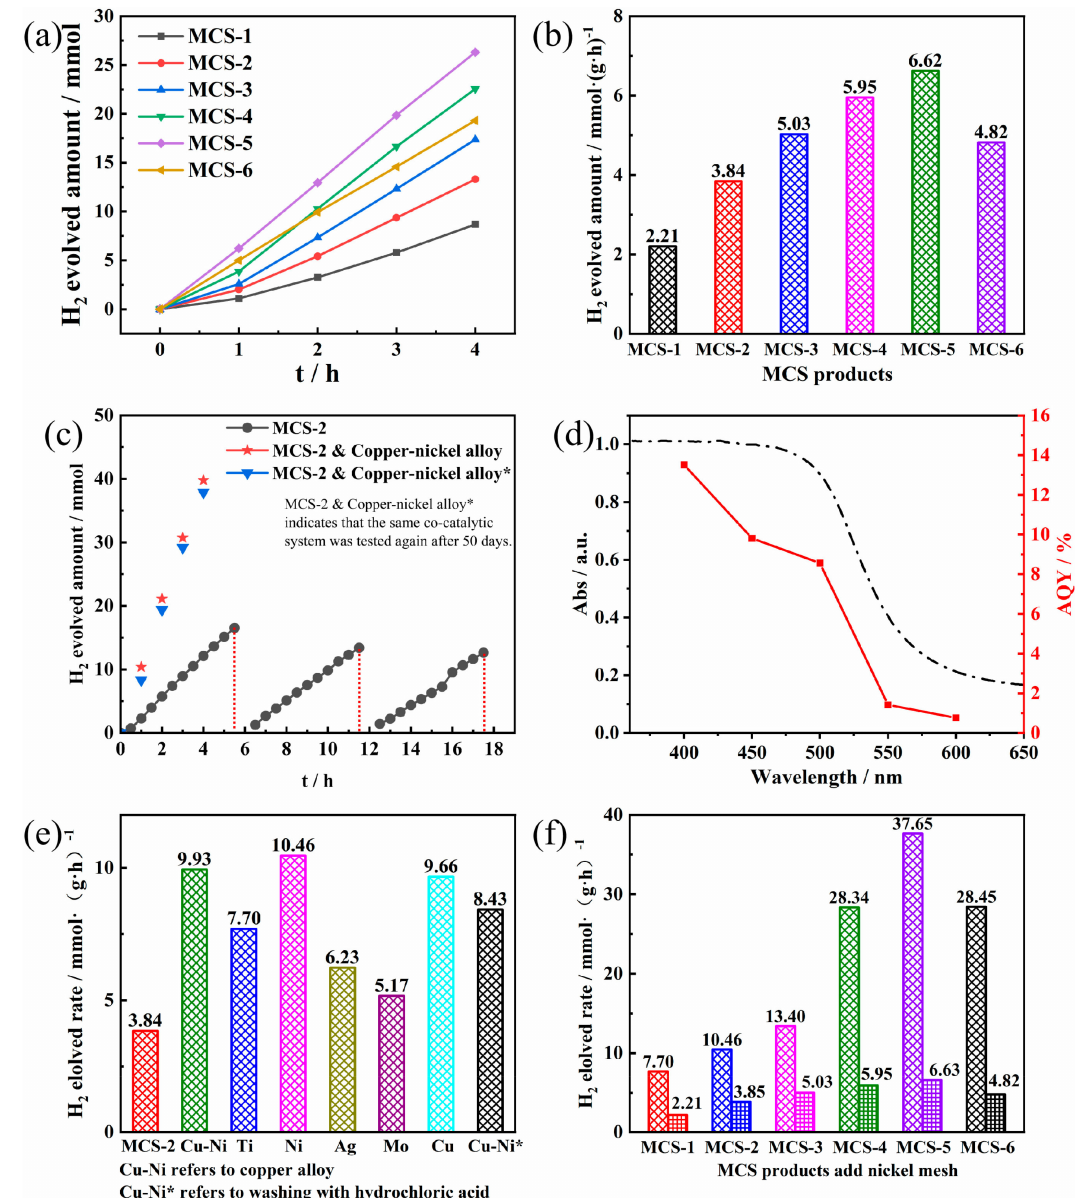
Figure 7. ( a , b ) H 2 production activity of MCS products with different TAA addition amounts. ( c ) Photostability study and ( d ) apparent quantum yield for H 2 production for MCS-2 (5 mg) from 50 mL of Na 2 SO 3 (0.25 M)-Na 2 S (0.35 M) aqueous suspension system. ( e ) H 2 production activity of MCS-2 with different metal mesh contents. ( f ) Comparison diagram of hydrogen production before and after the addition of the nickel